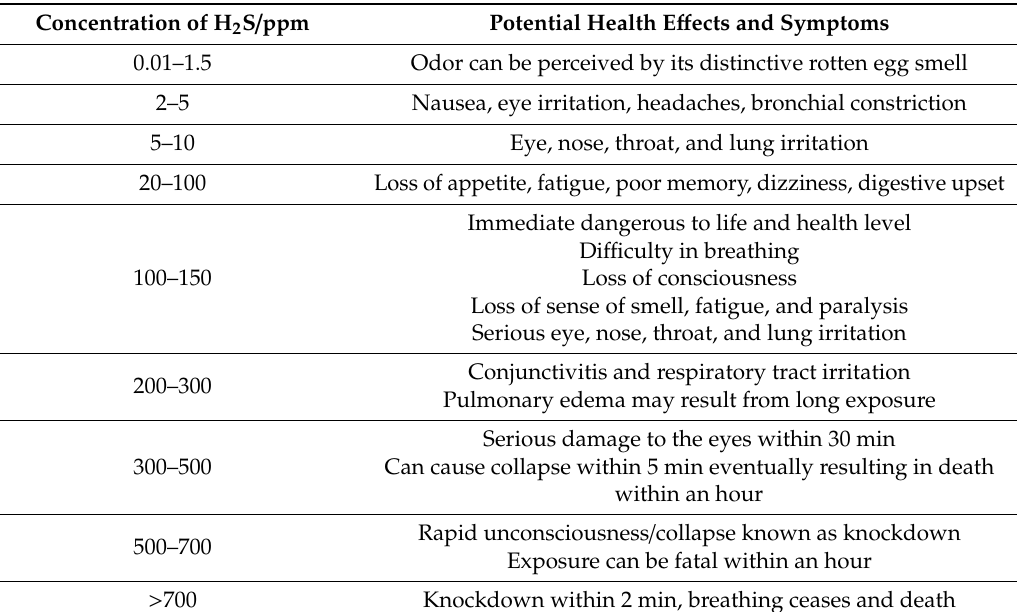
Table 1. Symptoms and health e ff ects resulting from exposure to di ff erent concentrations of H 2 S